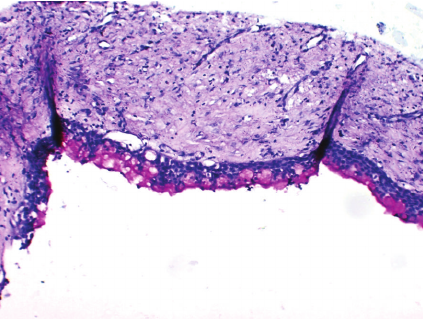
Figure 9: High power photomicrograph of the lesion showing glandular cystic lining with mucicarmine positive mucus cells (H&E, 20x).